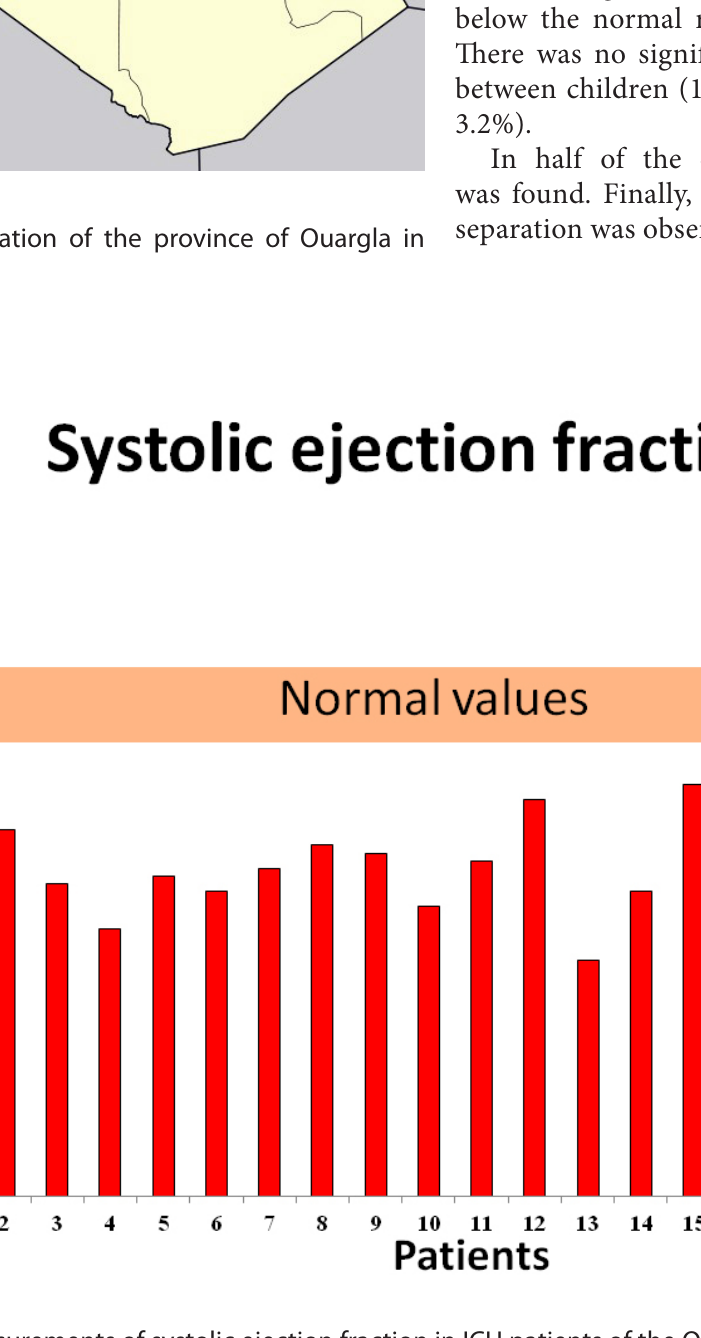
Figure 3. Measurements of systolic ejection fraction in ICU patients of the Ouargla Hospital (those treated with